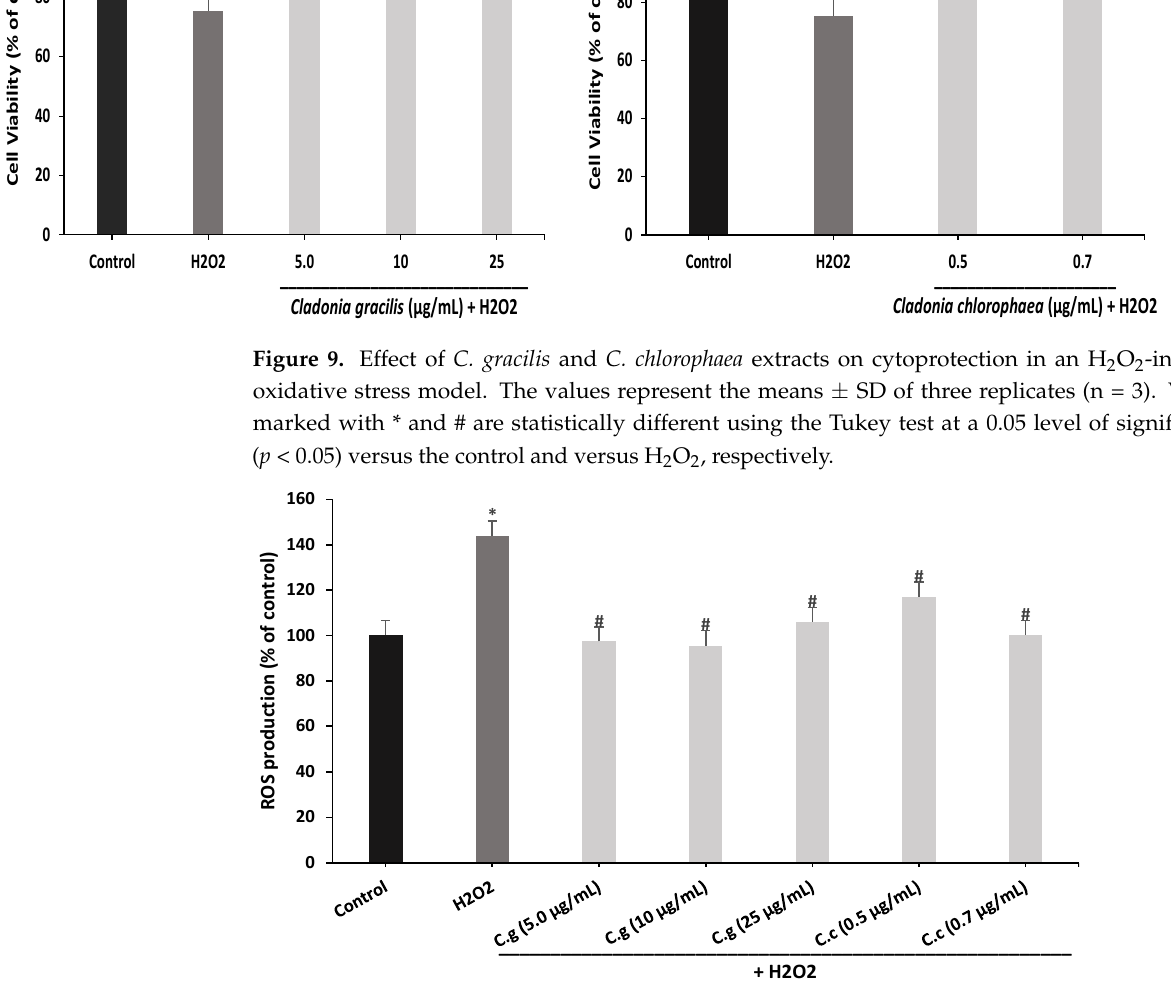
Figure 10. Effect of C. gracilis and C. chlorophaea extracts on intracellular ROS production. The values represent the means ± SD of three replicates (n = 3). Values marked with * and # are statistically different using the Tukey test at a 0.05 level of significance ( p ˂ 0.05) versus the control and versus H 2 O 2 , respectively. C.g: C. gracilis ; C.c: C. chlorophaea .